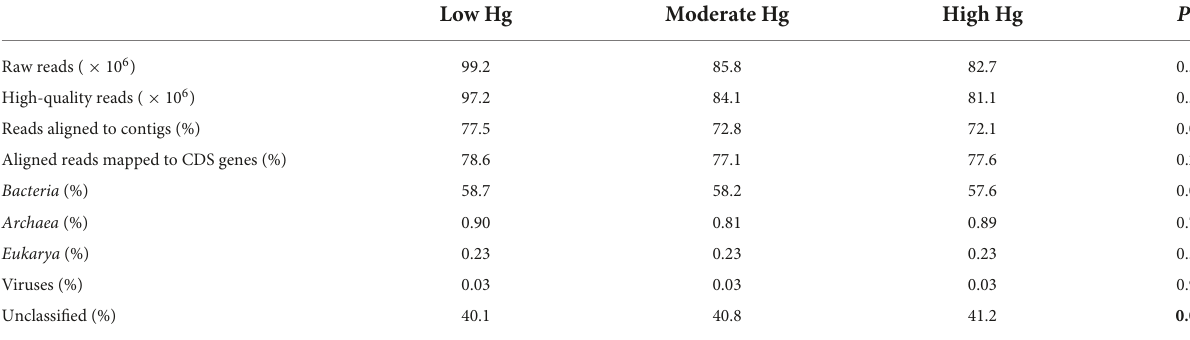
TABLE 2 Mean number of sequences and percentage of protein-coding genes (CDS genes), and the relative abundance of CDS assigned to taxa at the domain level for the three Hg contamination levels. Low